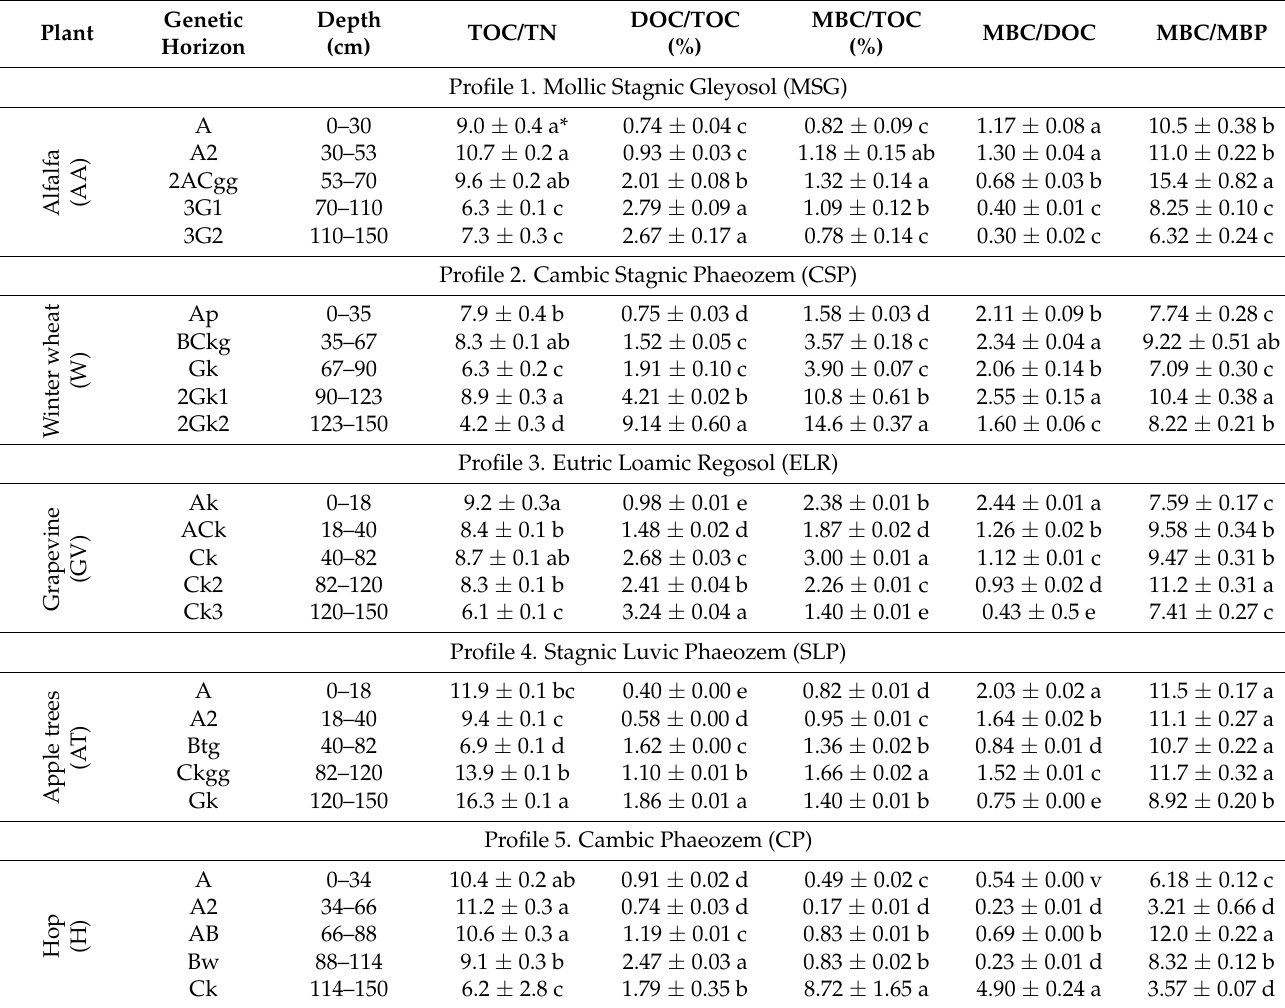
Table 3. Ratios of the studied